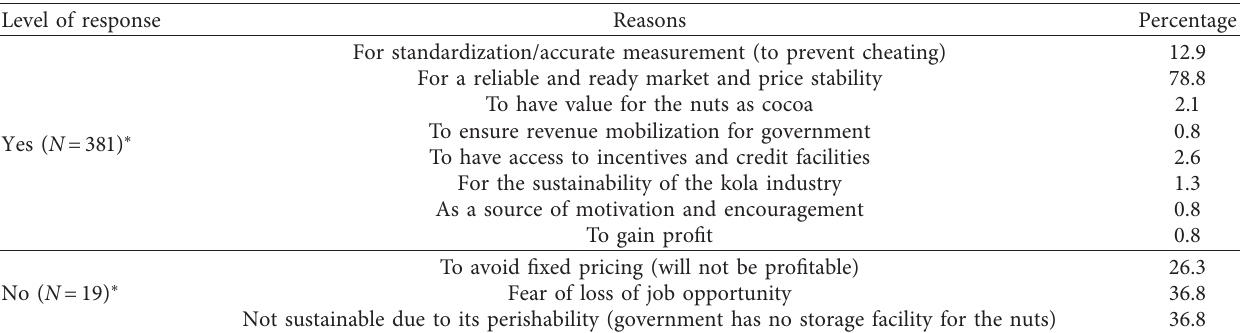
Table 15: Respondents’ reasons for why kola nuts marketing systems should or should not be controlled as for cocoa in Ghana. Level of